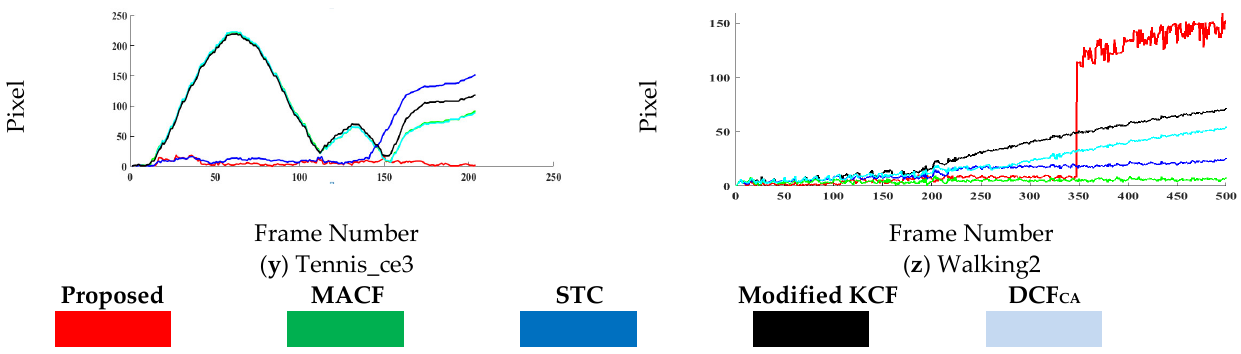
Figure 4. Center location error (in pixels) comparison on TC-128, OTB2013, OTB2015 and UAV123 datasets.